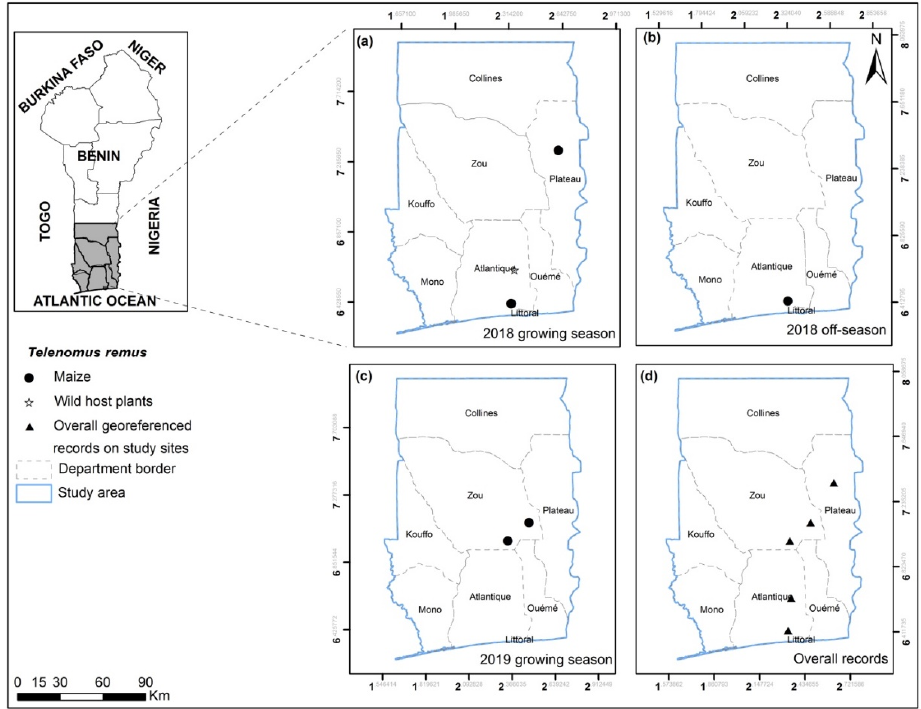
Figure 9. Telenomus remus georeferenced records on maize, wild and other cultivated host plants for the years 2018 and 2019 on the study sites for growing ( a , c ) and off ‐ seasons ( b ) in southern and central Benin ( d ). No T. remus were found in the 2019 or 2020 off ‐ season.